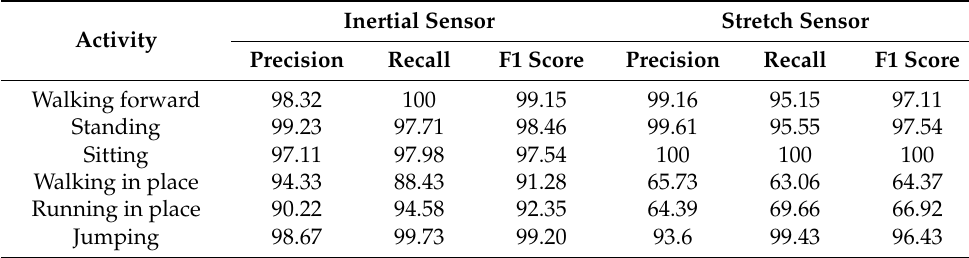
Table 3. The recognition precision, recall, and F1 score for various activities in the IS-Data dataset (%).